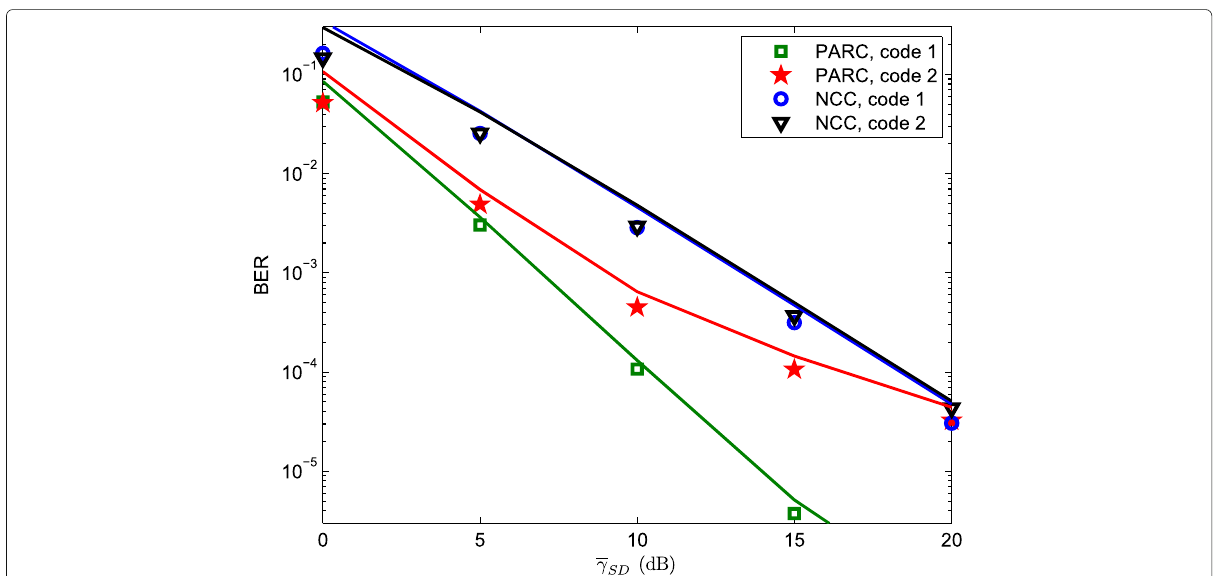
Fig. 3 Validation of the analysis for both PARC and NCC. Markers show simulation results, solidcurves correspond to the bounds in (10) and (13). N r = 2, code 1: [133 165 171], code 2: [5 7